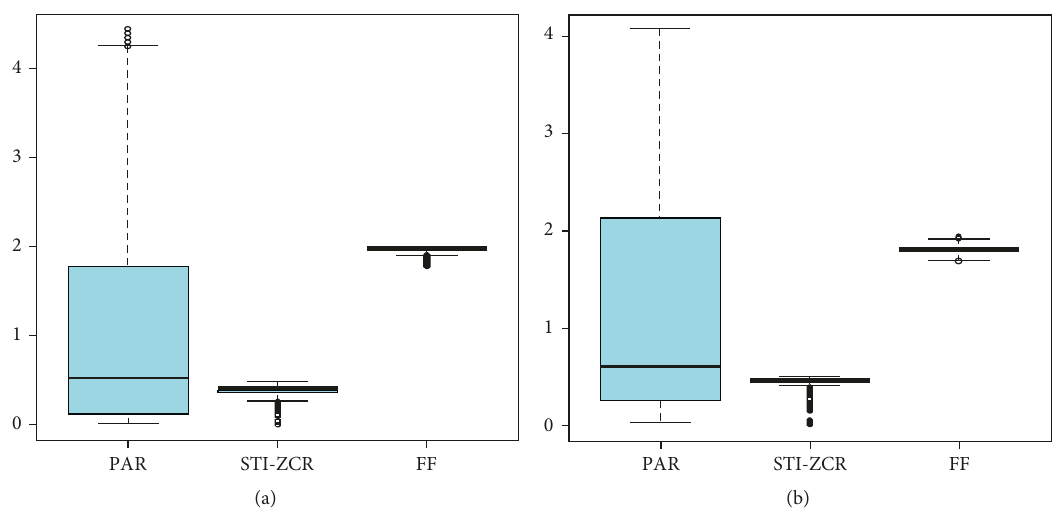
Figure 5: Hybrid feature distribution of gas pipelines. (a) Hybrid features of gas leakage pipelines. (b) Hybrid features of gas nonleakage